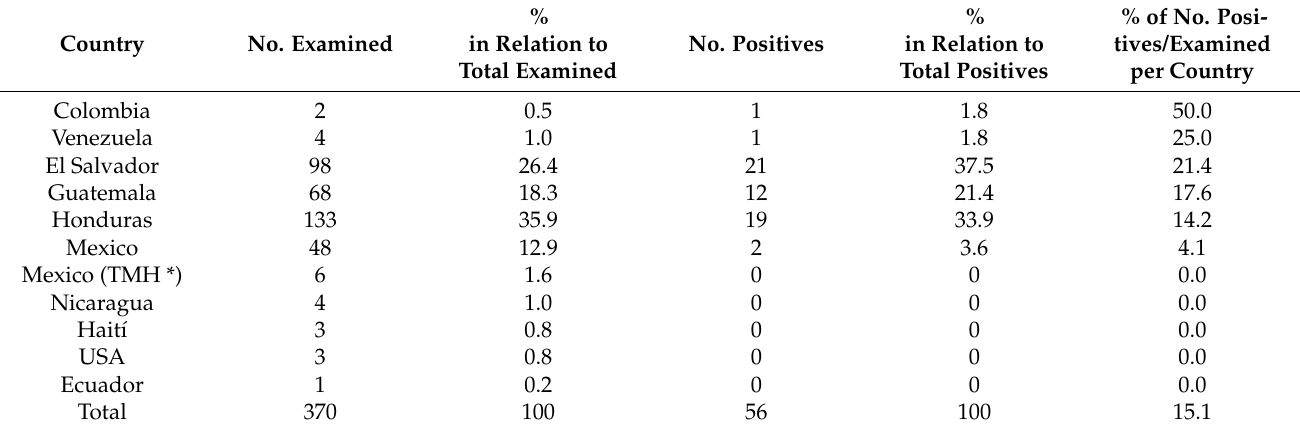
Table 1. Percentages of migrants from 10 countries examined and tested positive for